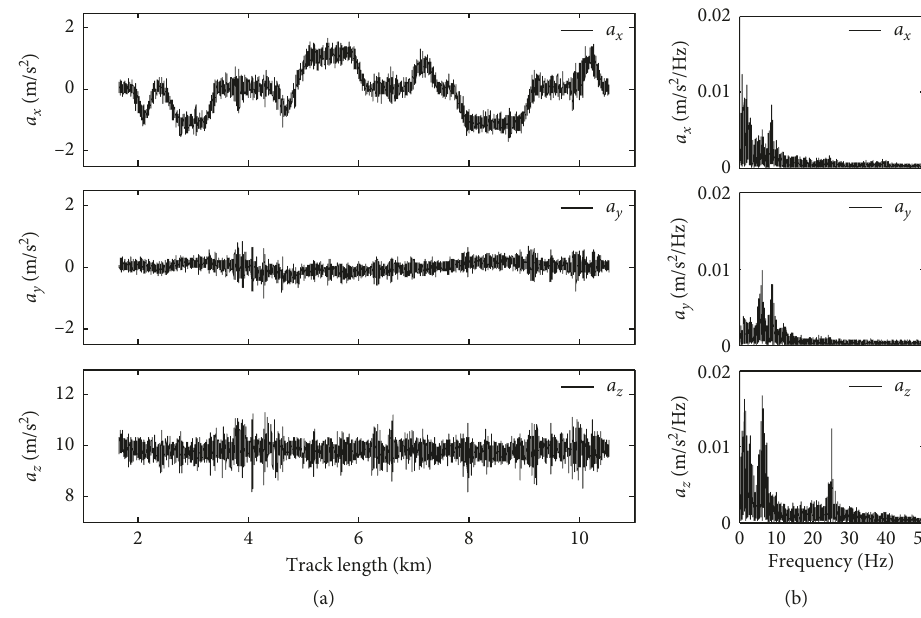
Figure 3: Acceleration measurements: (a) measurements along the track; (b) frequency